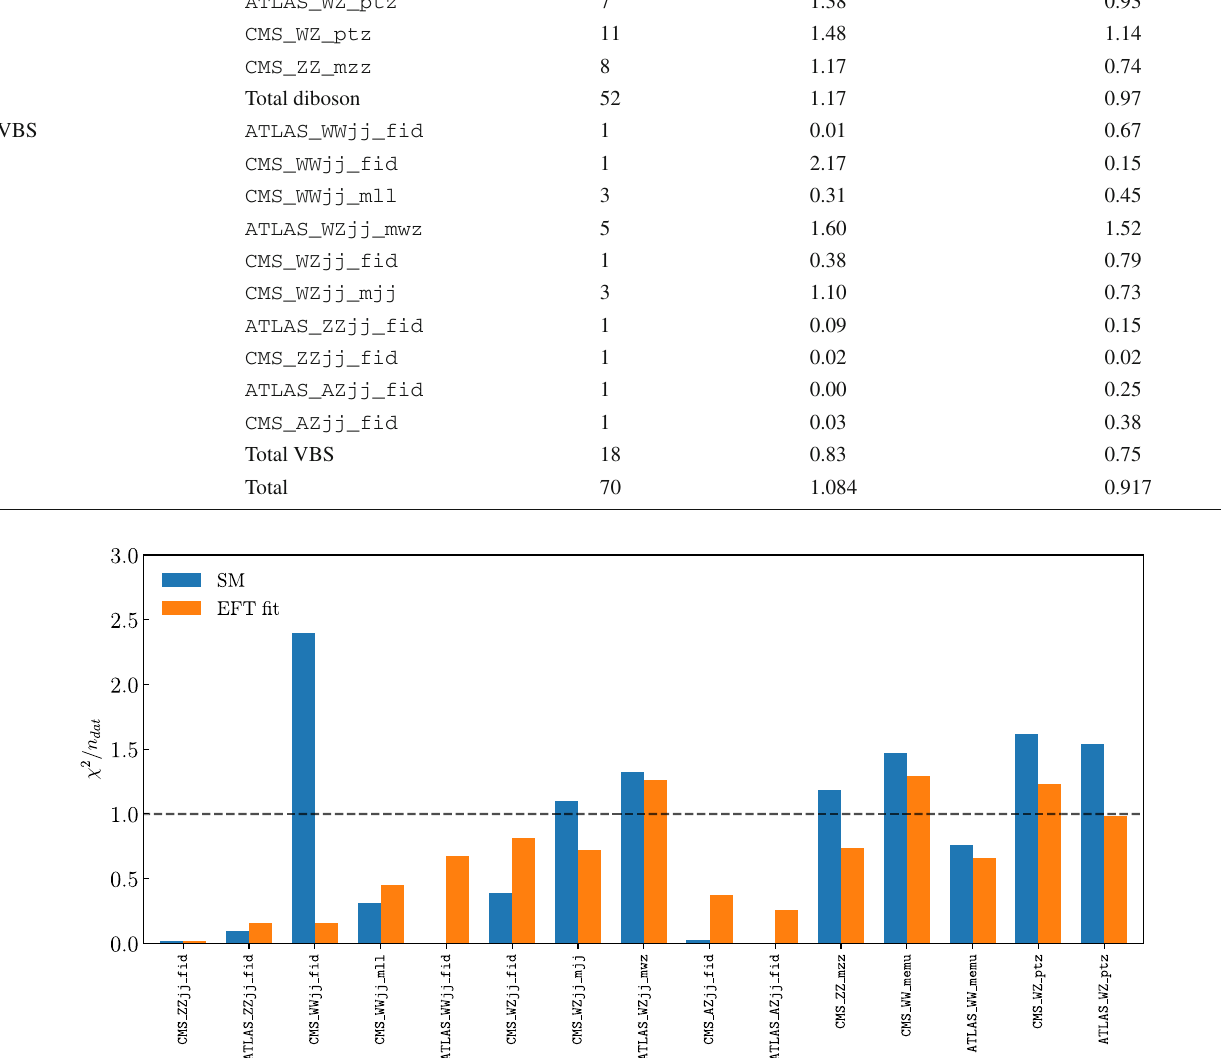
Fig. 16 Graphical representation of the χ 2 values reported in Table